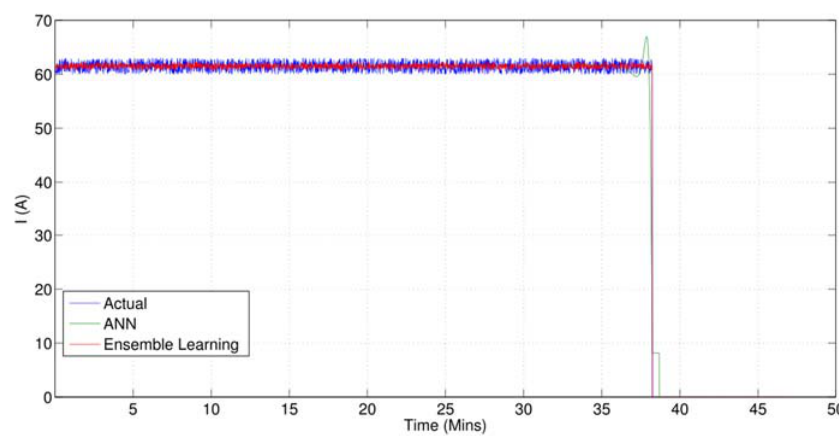
Figure 16. Normalized CPU cost as a function sample size.